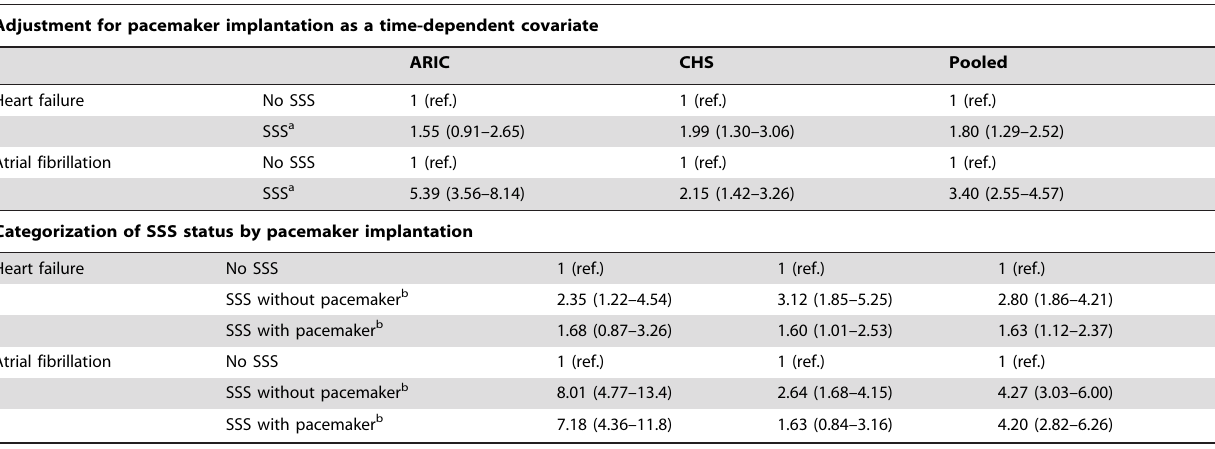
Table 3. Cohort-specific and pooled hazard ratios (95% confidence intervals) for the association of sick sinus syndrome (SSS) with atrial fibrillation and heart failure, adjusting for cardiovascular risk factors and accounting for pacemaker implantation, Atherosclerosis Risk in Communities (ARIC) study, 1987–2009, and Cardiovascular Health Study (CHS), 1989–2008.